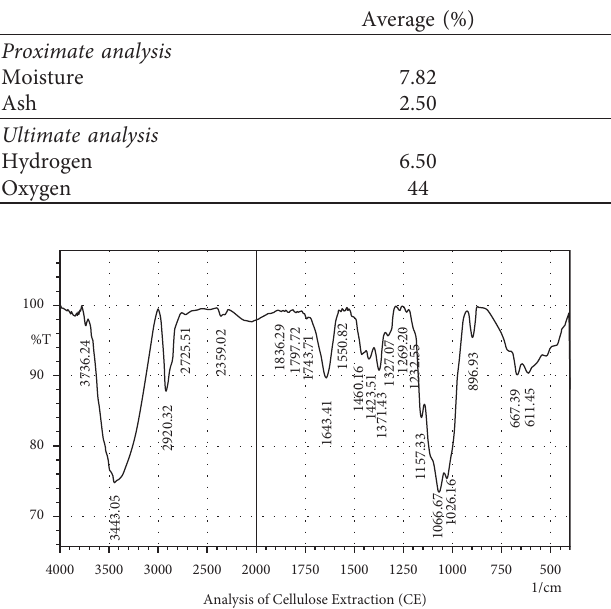
Figure 2: The results of the analysis of cellulose extraction (CE) using FTIR.